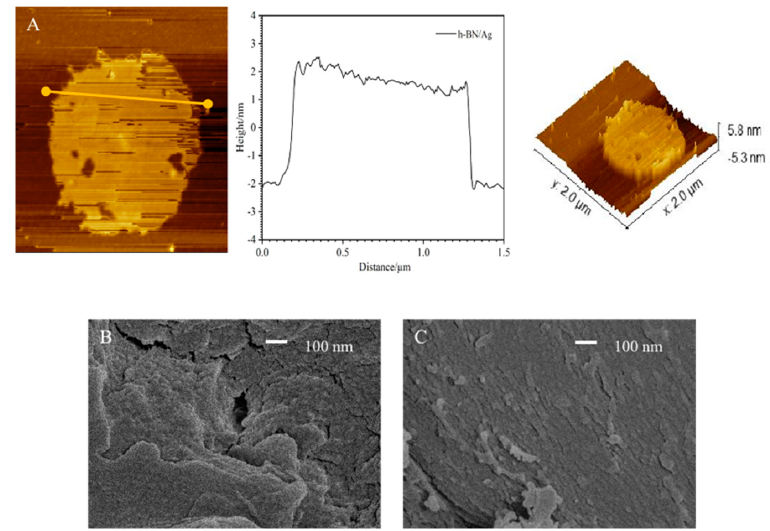
Figure 3 . ( A ) AFM image of h ‐ BNNs/AgNPs ( B ) SEM image of hAP (0 wt%) ( C ) SEM image of frac ‐ Figure 3. ( A ) AFM image of h-BNNs/AgNPs ( B ) SEM image of hAP (0 wt%) ( C ) SEM image of ture surface of hAP (1 wt%) . fracture surface of hAP (1 wt%).